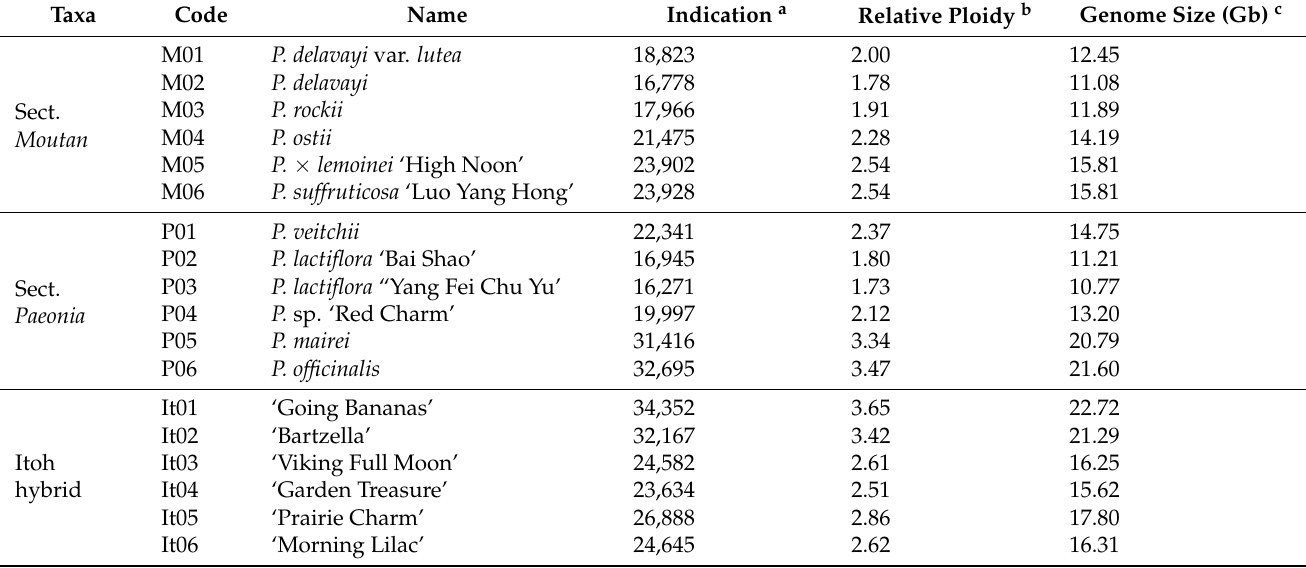
Table 1. Information and relative genome size of 18 species or varieties in Paeonia